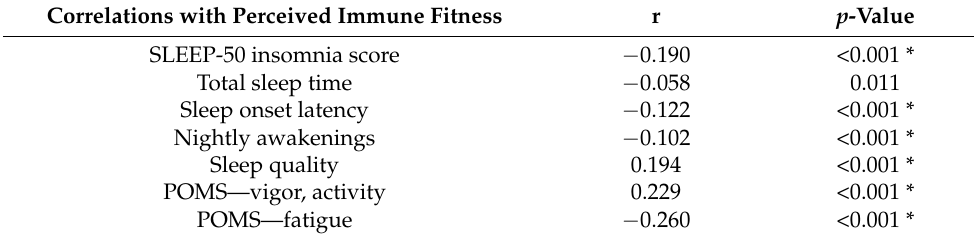
Table 5 lists the Spearman’s correlations between perceived immune fitness and sleep outcomes. Except for the total sleep time, all correlations were statistically significant. Table 5. Correlations between perceived immune fitness and sleep outcomes. Correlations with Perceived Immune Fitness r p -Value SLEEP-50 insomnia score − 0.190 <0.001 * Total sleep time − 0.058 0.011 Sleep onset latency − 0.122 <0.001 * Nightly awakenings − 0.102 <0.001 * Sleep quality 0.194 <0.001 * POMS—vigor, activity 0.229 <0.001 * POMS—fatigue − 0.260 <0.001